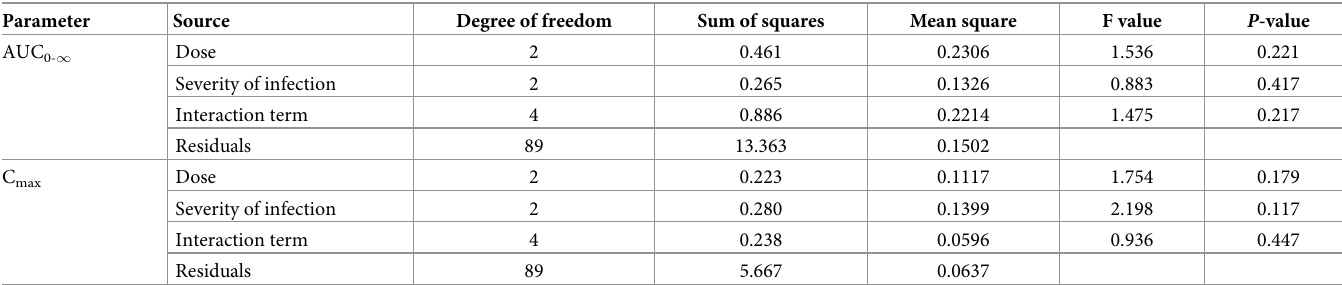
Table 4. Summary of analysis of variance for dose-normalized exposure parameters of moxidectin.